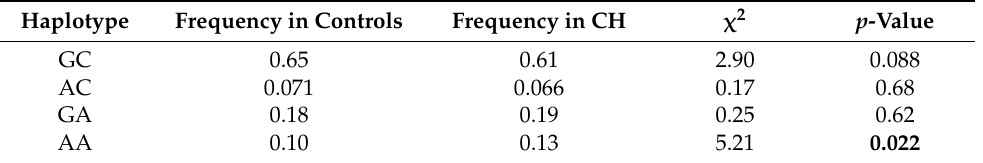
Table 3. Results from the rs2297518|rs2779249 iNOS haplotype analysis. Haplotype